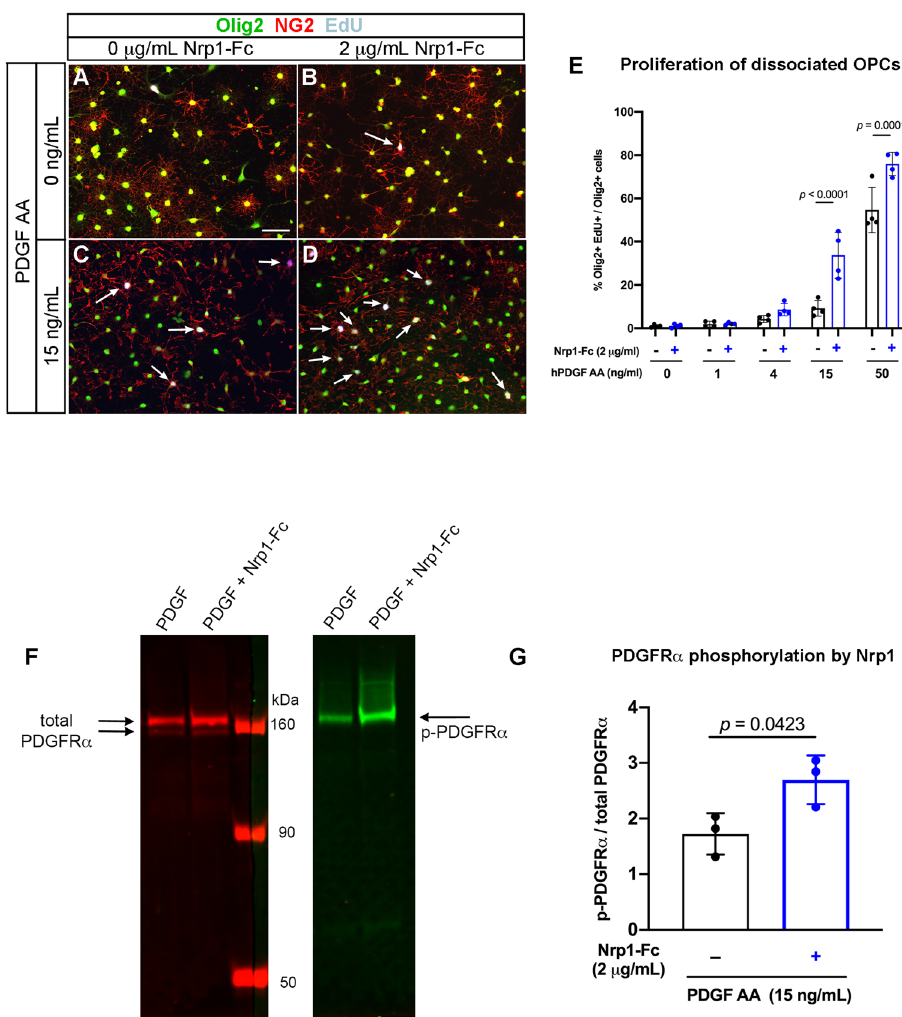
Fig. 7 Effects of Nrp1-Fc on dissociated cultures of OPCs. A – D Immunolabeling for Olig2 (green), NG2 (red), and EdU (gray) of cells grown in no PDGF AA ( A , B ) or 15 µ g/mL PDGF AA in the absence ( A , C ) or presence of 2 µ g/mL Nrp1-Fc ( B, D ). Scale in A , 50 µ m. Arrows: EdU + Olig2 + NG2 + cells. E Quanti fi cation of the effects of combination of PDGF AA and Nrp1-Fc on OPC proliferation. Two-way ANOVA, Sidak ’ s multiple comparisons test, n = 4, F (1, 30) = 36.29. F Immunoblots of OPCs treated with 15 ng/mL of PDGF AA alone or 15 ng/mL of PDGF AA and 2 µ g/mL Nrp1-Fc immunostained with antibody to total PDGFR α (left, red) or phosphorylated PDGFR α (right, green). Arrows indicate the expected bands for PDGFR α and phosphorylated PDGFR α . G Quanti fi cation of the intensity of the phosphorylated PDGFR α band relative to total PDGFR α bands. ** p = 0.0081, Student ’ s t -test, paired, two- tailed n = 3, t = 2.453, df = 2. Black, absence of Nrp1-Fc; blue, presence of 2 μ g/mL Nrp1-Fc. Source data are provided as a Source Data